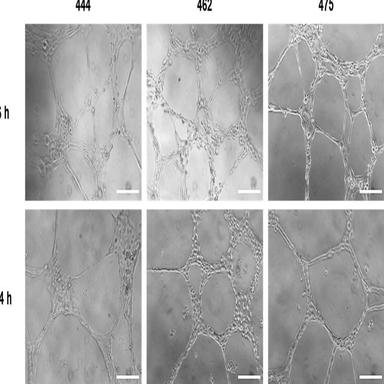
Endothelial cell tube formation assay on Matrigel. upcyte® LSECs were seeded with 25,000 cells per 48-well on Matrigel Basement Matrix. Light microscopy images were taken at 6 and 24 h after seeding. Images are representative from two independent experiments. Bar - 10 µm.